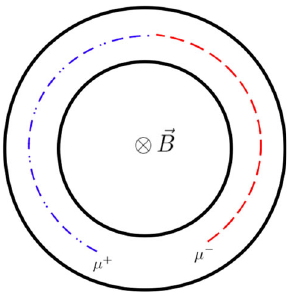
Fig. 2 For a magnetic field B into the page, the positive muon μ + follows the circle in blue (dot-dashed line), while the negative muon follows the red circle (dashed